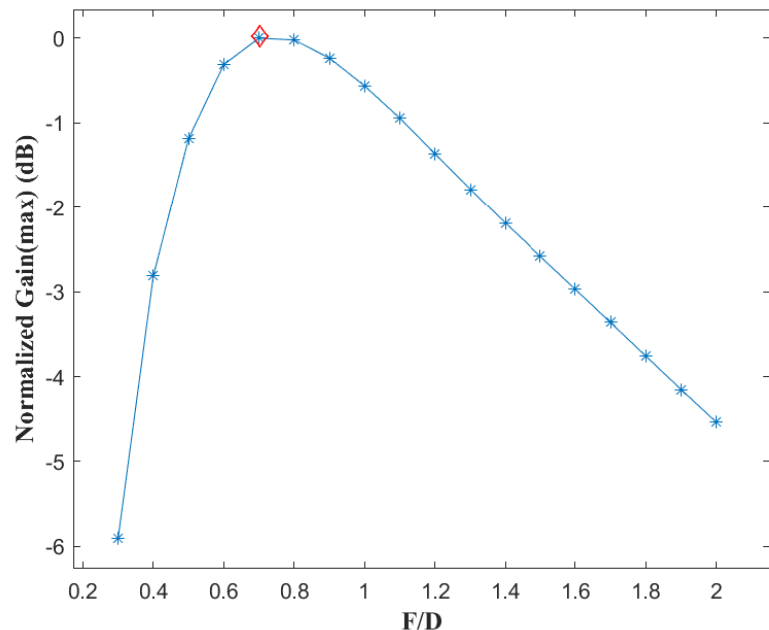
Figure 3. Peak gain of F / D = 0.3:0.1:2.0.